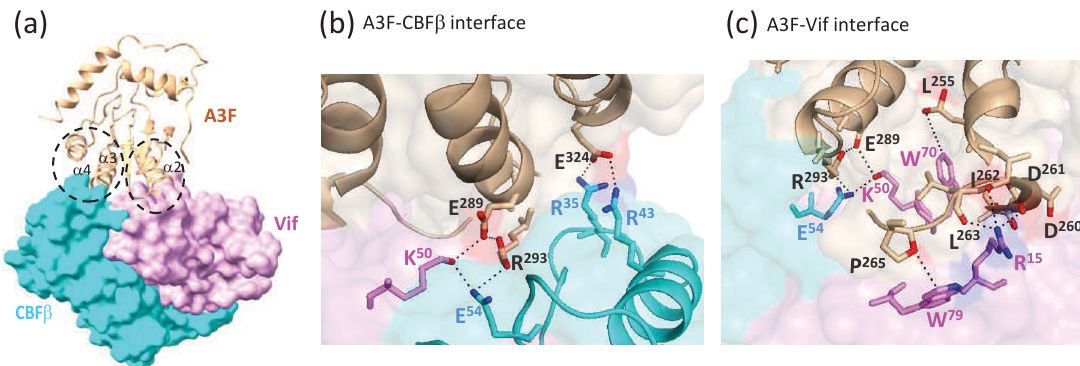
Figure 5. Ternary A3F CTD -Vif-CBF β complex and the role of CBF β -Vif dimer in recruiting A3F CTD to the CRL5 E3 ubiquitin ligase complex. ( a ) Overall structure of A3F CTD -Vif–CBF β ternary complex. Vif (magenta) and CBF β (cyan) form a shallow wedge-like platform for A3F CTD (orange) to dock primarily via the α 2-helix on Vif and the α 3- and α 4-helical surface on CBF β . ( b ) Detailed illustrations of the A3F-CBF β interface and interacting residues that form two distinct electrostatic interfaces; the first involves A3F (E289 and R293), CBF β (E54), and Vif (K50); the second involves A3F (E324) and CBF β (E35 / E43). ( c ) Detailed illustrations of the A3F-Vif interface and interacting residues. The extensive hydrophobic and electrostatic A3F-Vif interactions are indicated with dashed lines and all critical residues involved in the interactions are shown in stick